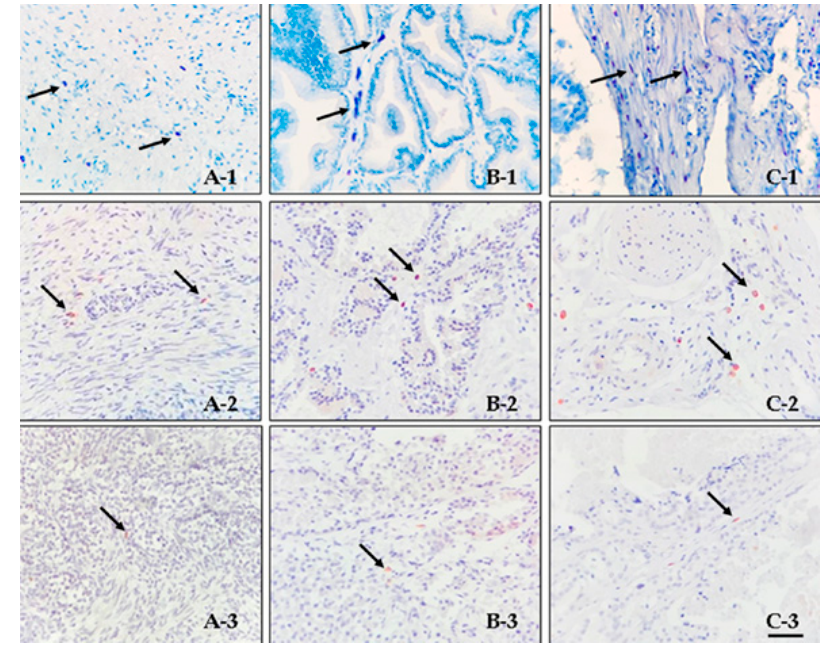
Figure 2. Mast cells (MCs) (indicated by arrows) in canine prostate tissues. ( A )—normal; ( B )—benign prostate hyperplasia (BPH); ( C )—prostate carcinoma (PC). 1-Toluidine Blue (TB) staining: ( A-1 ) Scattered MCs as single elements in normal periglandular stroma; ( B-1 ) small groups of MCs in BPH intraglandular stroma; ( C-1 ) numerous MCs detected in peritumoral stroma. 2-Tryptase immunostaining: scattered, trypase-positive MCs in periglandular and intraglandular stroma of normal ( A-2 ) and BPH ( B-2 ) samples, respectively, as well as in the peritumoral stroma of a PC case ( C-2 ). 3-C-Kit immunostaining: scattered, c-Kit-positive MCs in periglandular and intraglandular stroma of normal ( A-3 ) and BPH ( B-3 ) samples, respectively, as well as in the peritumoral stroma of a PC case (C). No c-kit immunostaining is evident in prostate cells in each case. Bar = 50 μ m.